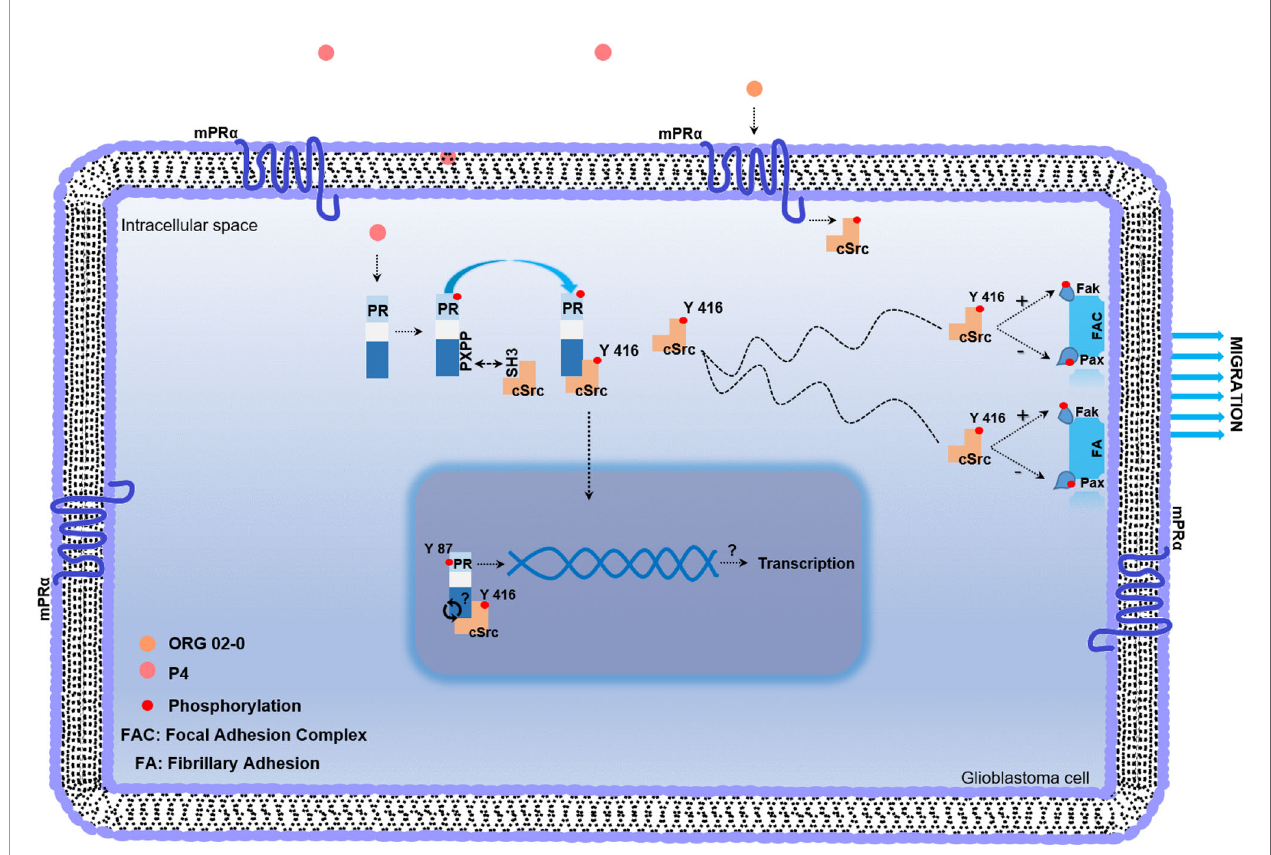
FIGURE 4 | Working model of non-genomic PR mechanism of action in glioblastoma cell. Once P4 enters the cell, it induces phosphorylation of PR in serine and threonine residues. After activation, PR recruits cSrc through the interaction between the polyproline (PXPP) and the SH3 domains of PR and cSrc, respectively. This interaction induces a conformational change in cSrc, which exposes its catalytic domain, and promotes the autophosphorylation of cSrc. Once activated, cSrc participates in regulating the phosphorylation of focal adhesion and fi brillary adhesion components such as Fak and Pax, which fi nally lead to the migration process. mPRs are expressed in glioblastoma cells and the agonist of mPR a (ORG 02-0) induces the activation of cSrc. The putative role of cSrc in the tyrosine 87 phosphorylation of PR could be involved in the transcriptional activity of PR.